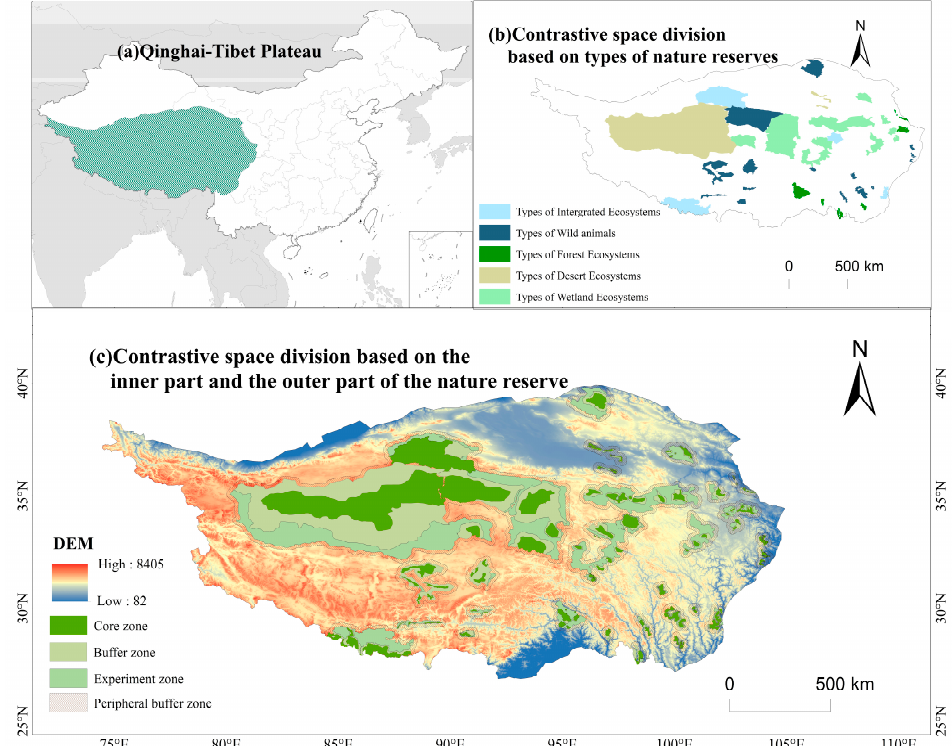
Figure 1. Location of the Qinghai–Tibet Plateau and the distribution of NRs and their functional zones.